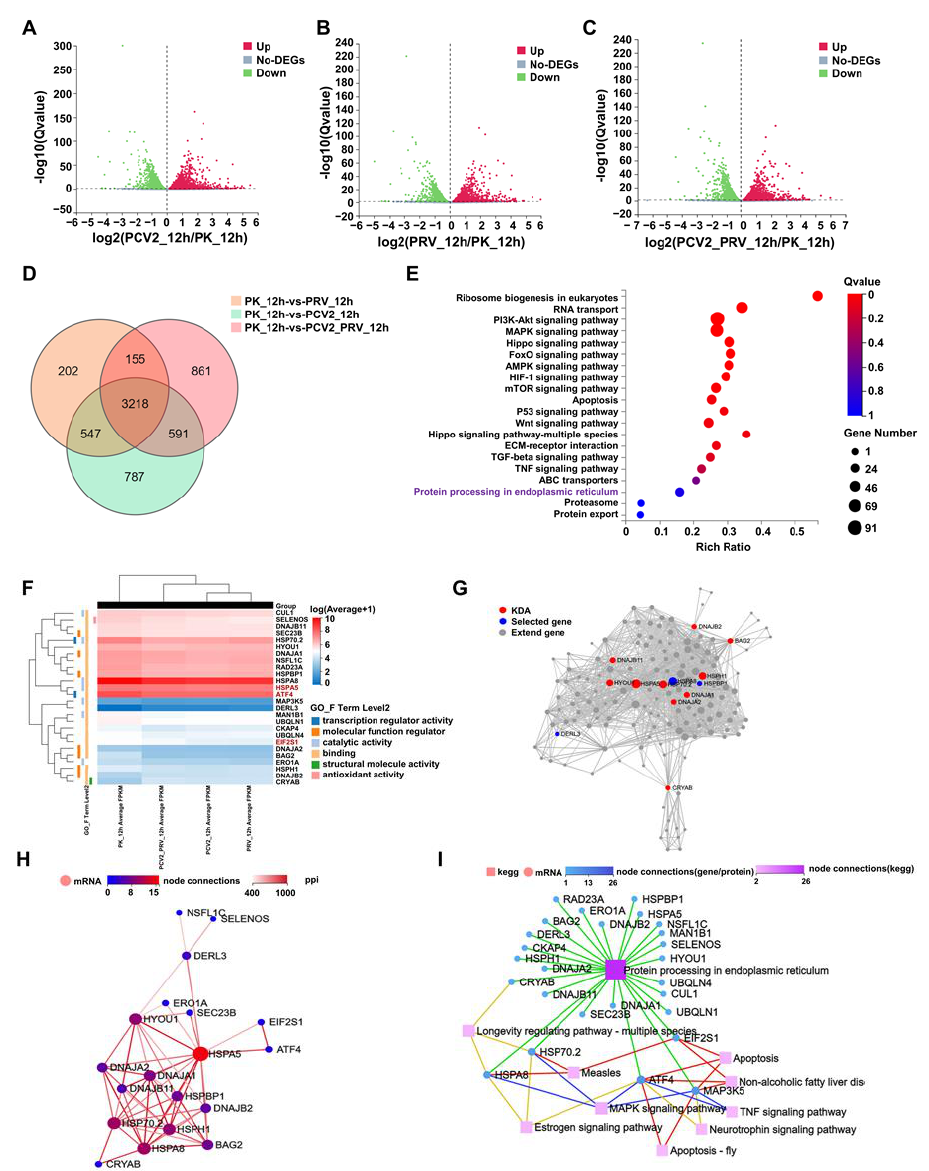
Figure 3. Results of transcriptome analysis. ( A – C ) Volcano plot of DEGs in PCV2 ( A ), PRV ( B ), and PCV2+PRV ( C ) groups compared with that of the control group (PK-15) at 12 hpi. Significant DEGs were highlighted in green (downregulated DEGs, p < 0.05) and red dots (upregulated DEGs, p < 0.05). ( D ) Venn diagram of numbers of DEGs between the control group (PK-15 cells) and different infection groups at 12 hpi. ( E ) KEGG pathway enrichment. Circles indicate the numbers of enriched genes and colors mean the Q value. Q-value < 0.05 was a significant difference. ( F ) Heatmap and one-dimensional hierarchical clustering of DEGs. ( G ) Biological networks analysis of DEGs using key driver analysis (KDA). ( H ) Biological network analysis of DEGs using protein – protein interac- tion network (PPI network). ( I ) Biological network analysis of DEGs using KEGG.